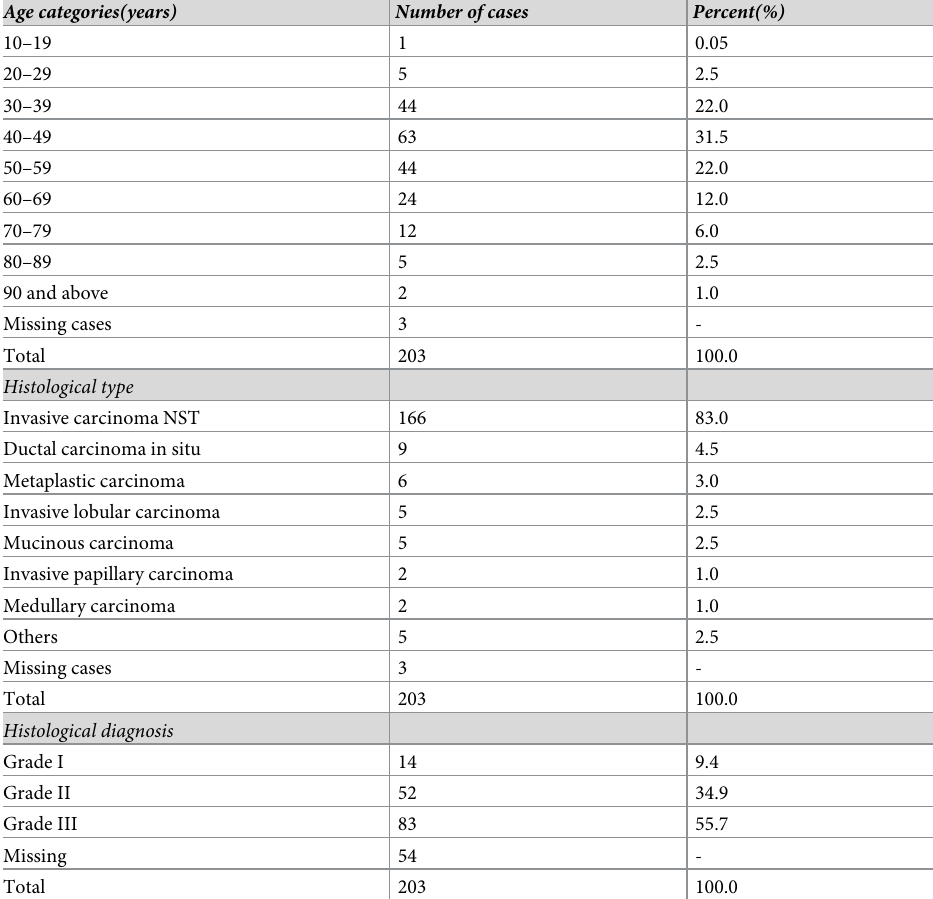
Table 2. Age and histological characteristics of patients with breast